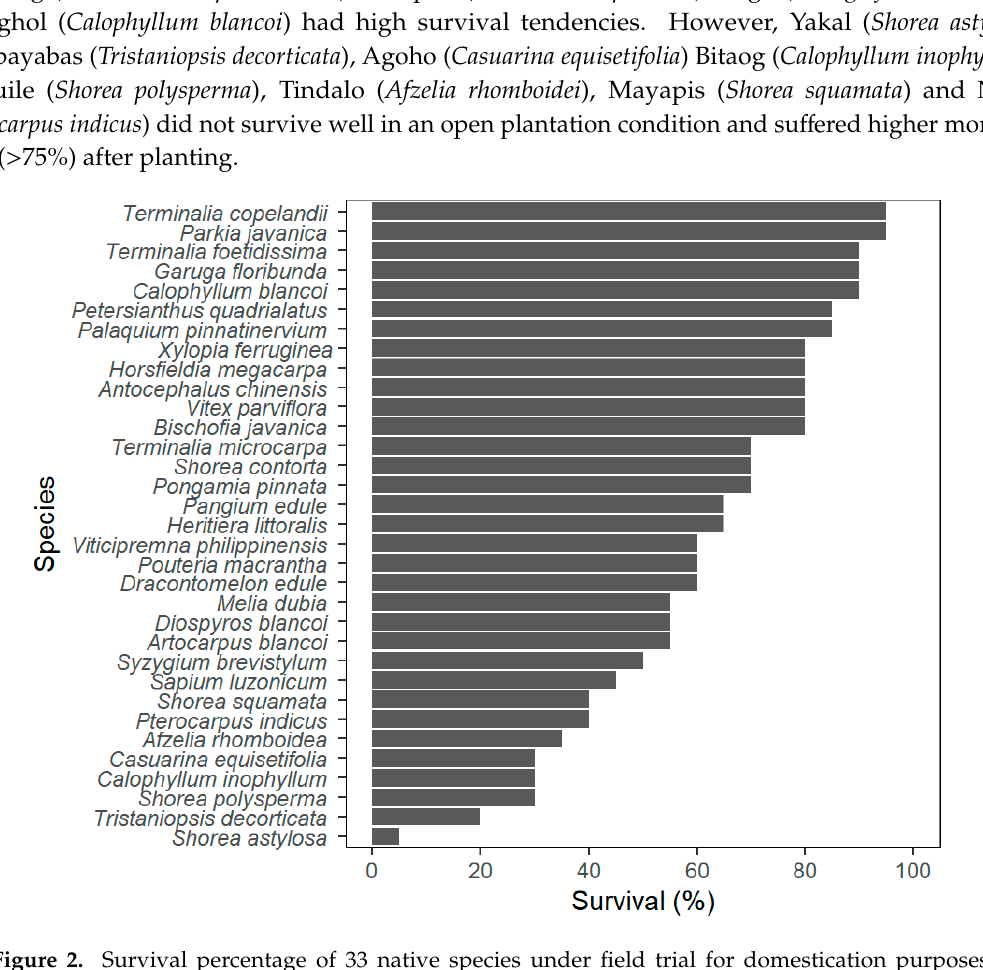
Figure 2. Survival percentage of 33 native species under field trial for domestication purposes. Bars represent the survival rate at the end of measurement period in 2018.